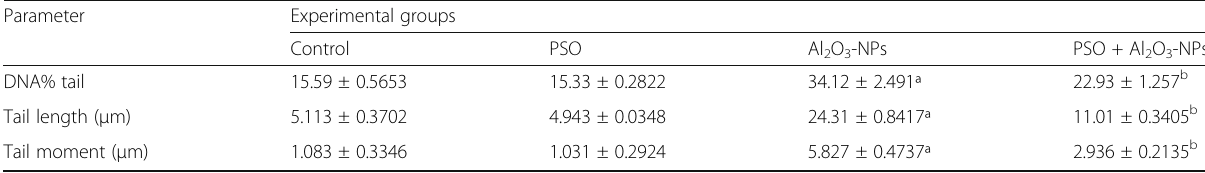
Table 2 Effect of pumpkin seed oil on the percentage of DNA damage (%DNA), tail length (TL), and tail moment (TM), in the testicular tissue of rat administrated with Al 2 O 3 -NPs